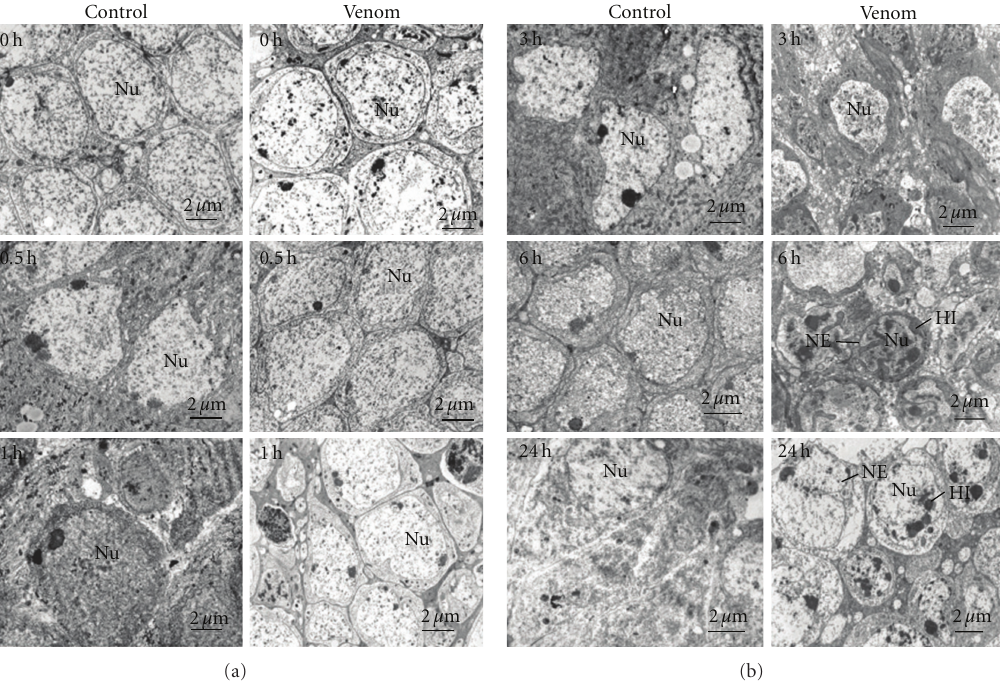
Figure 1: Ultrastructure of brains from young pharate adults of S. bullata following envenomation by N . vitripennis . At 0 and 0.5h postenve- nomation, neuronal cells in brain tissues from healthy and envenomated flies appeared virtually identical in appearance. Neuronal nuclei (Nu) were euchromatic with a regular oval shape. By 1 h and 3 h, neuronal nuclei displayed irregularity of shape with indentations in nuclear envelope (NE) and the cytoplasm became more electron dense. At 6 h after envenomation, large heterochromatic inclusions (HI) were evident within nuclei of many of the cells and the nuclei became very irregular in shape. By 24 h, large heterochromatic inclusions were present in nuclei of cells from envenomated flies. Nuclear envelopes remained intact but were irregular in